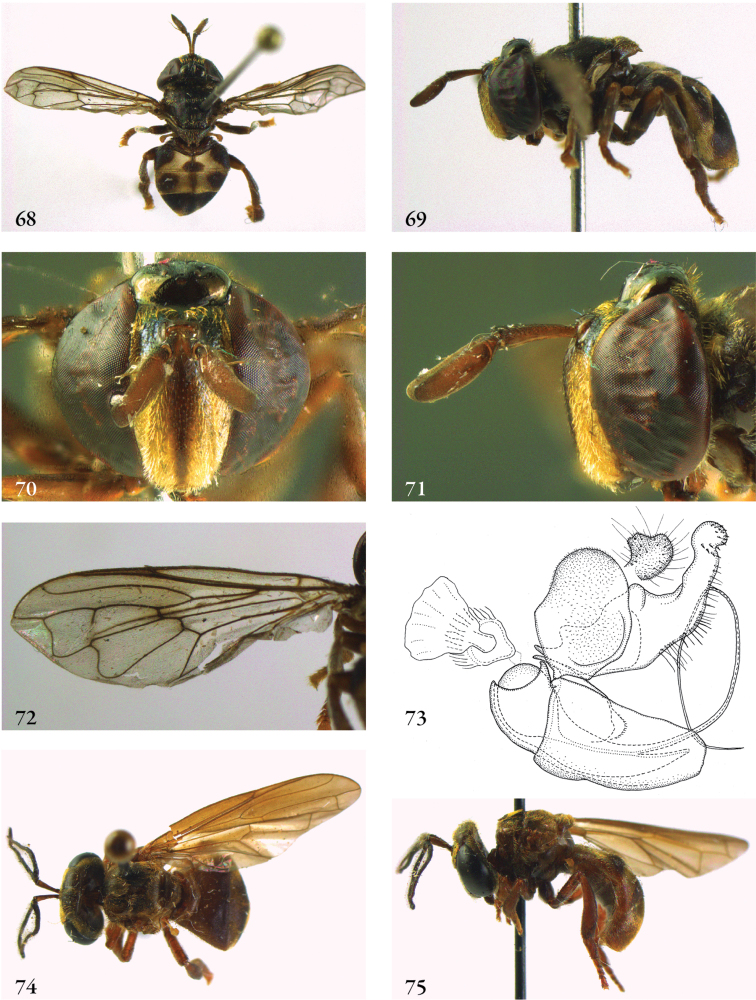
68–73
Domodon zodiacus male (holotype): 68 habitus dorsal 69 habitus lateral 70 head frontal 71 head lateral 72 wing 73 genitalia lateral 74–75
Furcantenna nepalensis male (holotype): 74 habitus dorsal 75 habitus lateral.